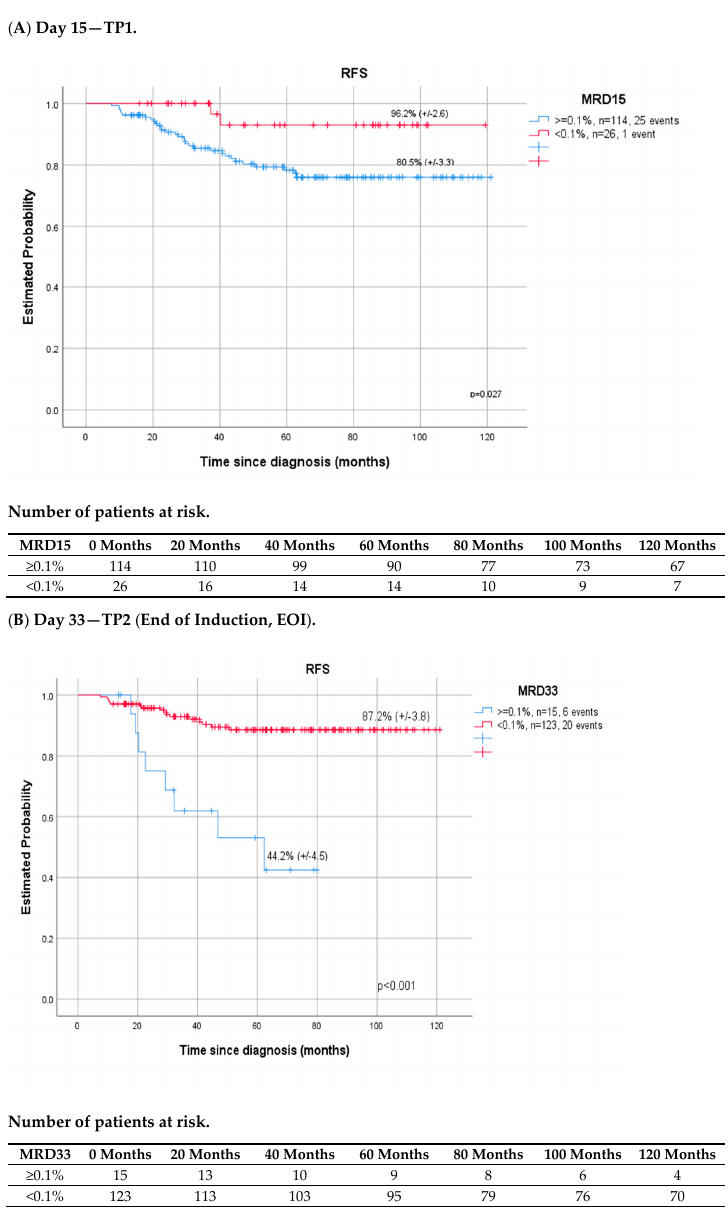
Cancers 2022 , 14 , x FOR PEER REVIEW 12 of 21 Bolded means statistically significant.